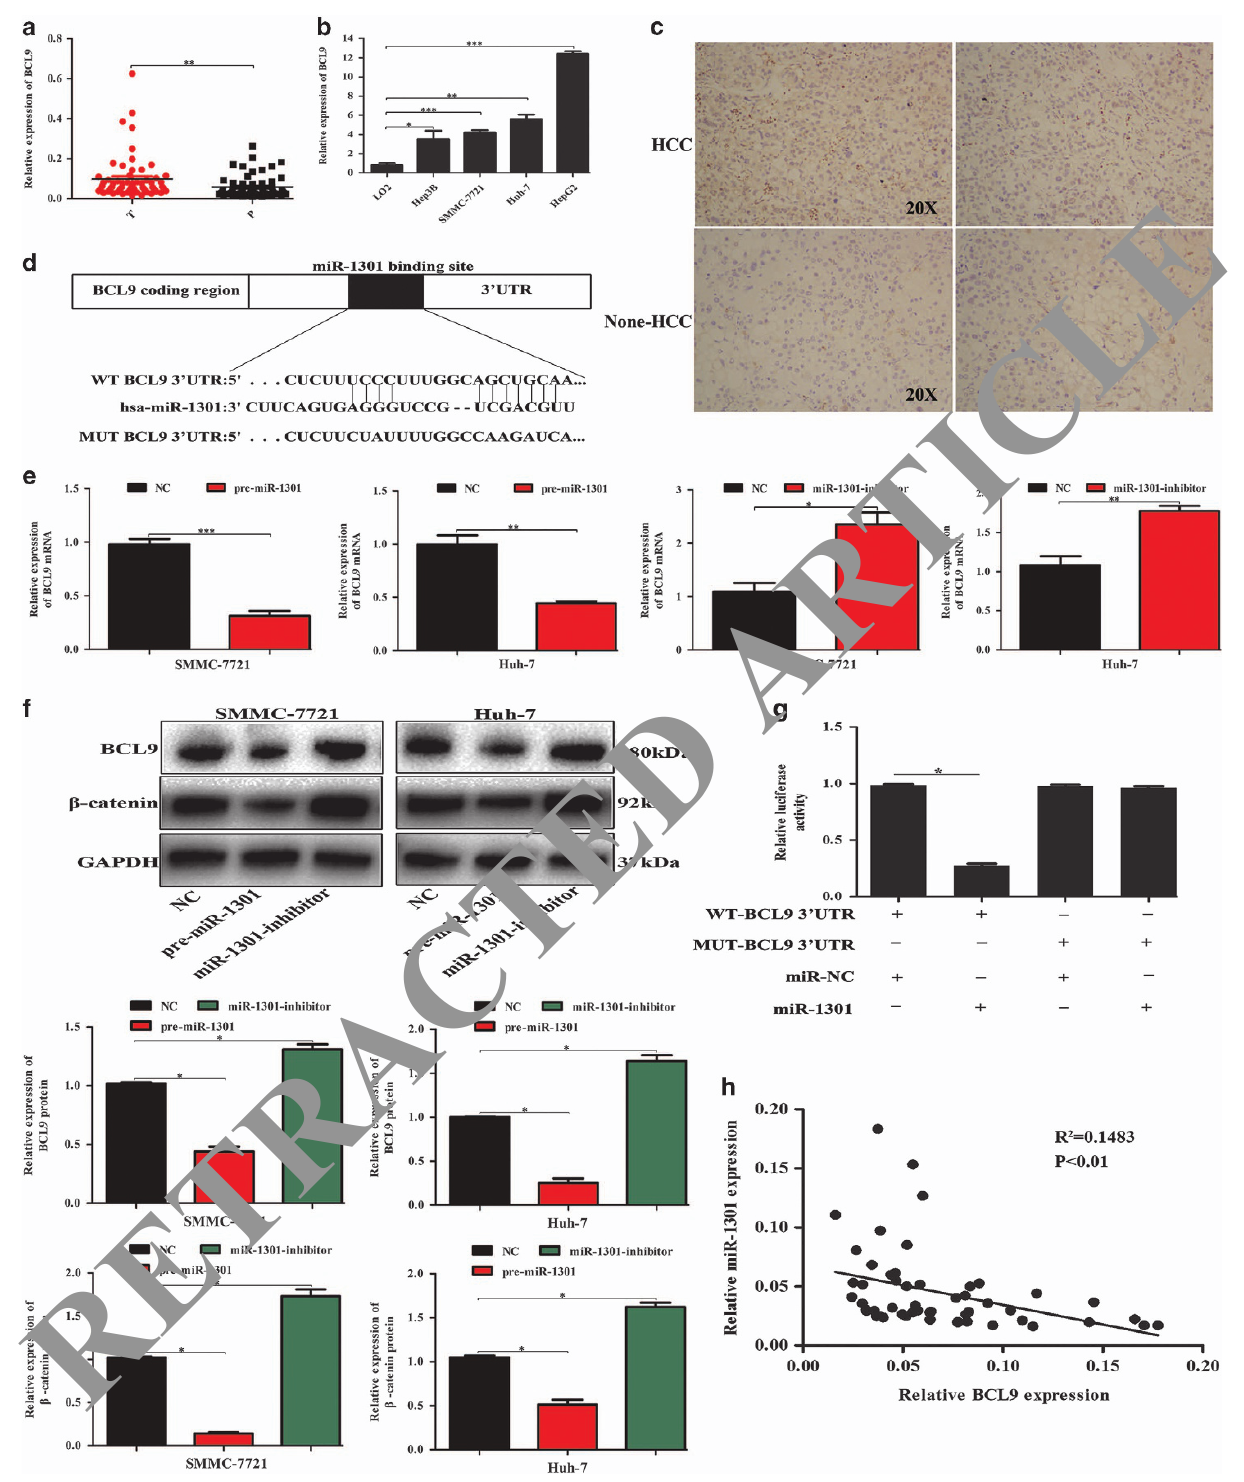
Figure 5 BCL9 was upregulated in HCC tissues and cell lines and is a direct miR-1301 target. ( a ) The levels of BCL9 expression were analyzed in 60-paired HCC and adjacent normal tissues by qPCR. ( b ) The levels of BCL9 expression in HCC cell lines and normal L02 cells. ( c ) BCL9 protein levels in HCC specimens and adjacent normal tissues as analyzed by immunohistochemistry. ( d ) The potential miR-1301 binding site in the BCL9 3 ′ -UTR was computationally predicted by TargetScan. ( e ) The level of BCL9 expression in cells after transfecting pre-miR-1301 or miR-1301-inhibitor as detected by qPCR; cells transfected with empty lentiviral vectors were used as a negative control. ( f ) BCL9 and β -catenin protein levels in HCC cells transfected with miR-1301 inhibitor or miR-1301 overexpression lentivirus. ( g ) Dual-luciferase reporter assay analysis of the effects of miR-1301 expression on the activities of wild type and mutant BCL9 3 ′ -UTR in 293 T cells. ( h ) A negative correlation between the levels of miR-1301 and BCL9 expression in HCC specimens ( P o 0.01). * P o 0.05, ** P o 0.01, *** P o 0.001